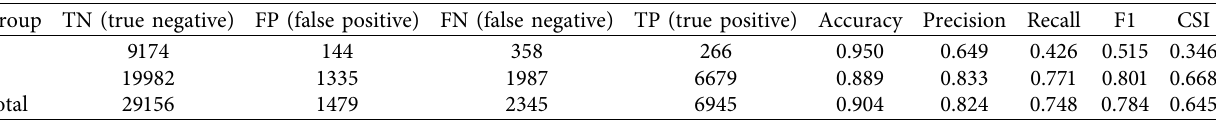
Figure 5: (a) K -means clustering visualization using the principal component analysis and (b) coastal distance and altitude scatter plot by group. Table 6: Results by group with XGBoost using weather